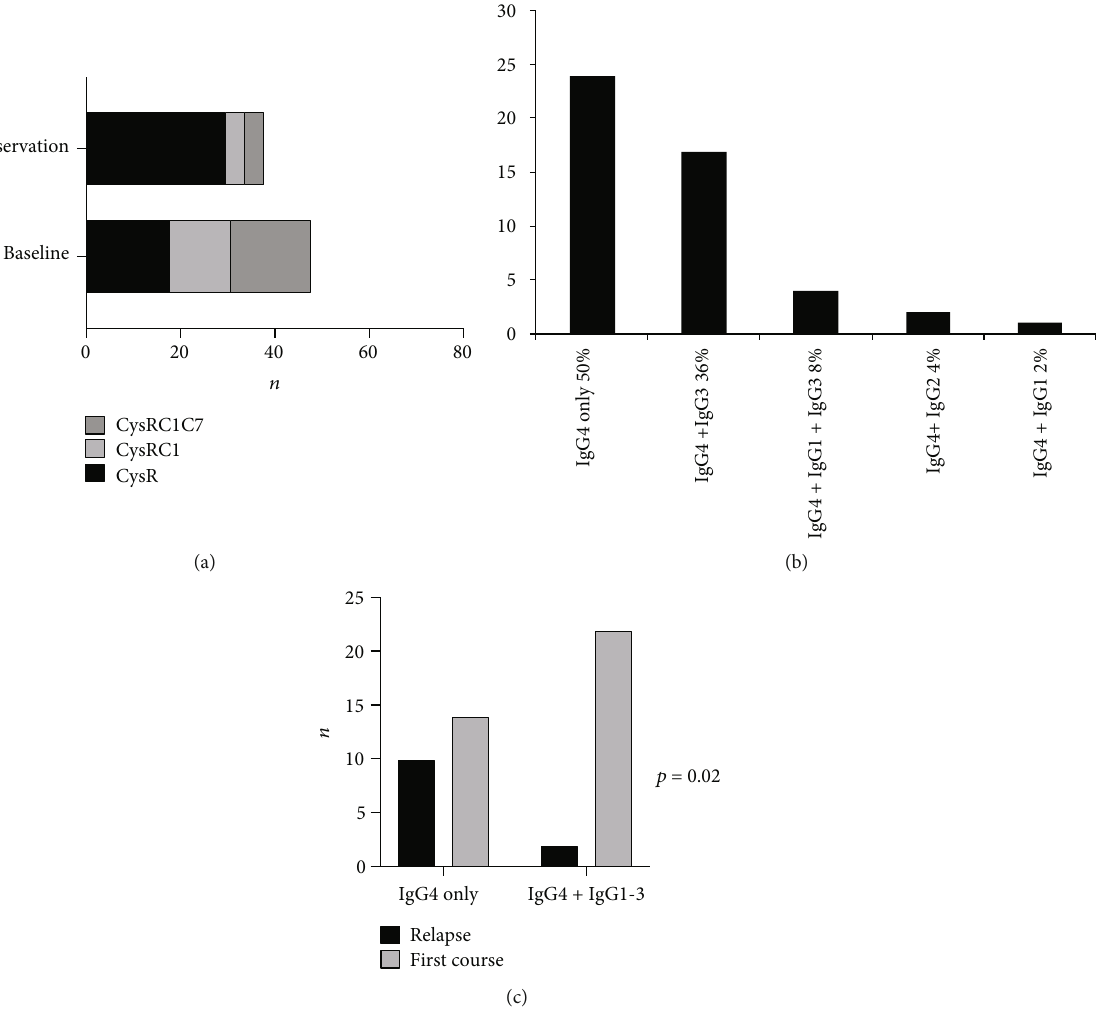
Figure 1: Description of samples with anti-PLA2R1 antibodies tested. (a) Epitope spreading pro fi les of patients at baseline ( n = 48 ) and at last observation ( n = 36 ). Follow-up was missing for 12 patients. C1: CTLD1; C7: CTLD7. CysR: immunized against CysR domain alone; CysRC1: immunized against CysR and CTLD1 domains; CysRC1C7: immunized against CysR, CTLD1, and CTLD7 domains. (b) IgG subclass pro fi les of patients at baseline ( n = 48 ). (c) IgG subclass pro fi les of patients according to disease course: fi rst course or relapse ( n = 48 ). Note that patients with the fi rst course of MN have a larger diversity of IgG subclasses ( p = 0 : 02